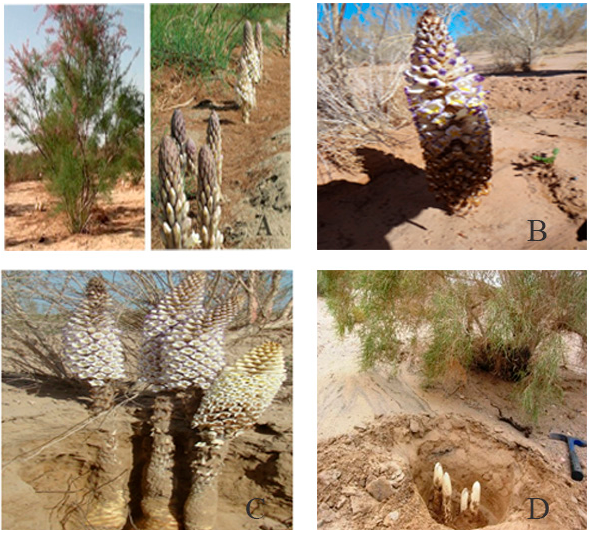
Figure 1. The growth environment ( A ); flowers- the aerial parts ( B ); the whole plants ( C ) and succulent stem collections ( D ) of Cistanche deserticola .